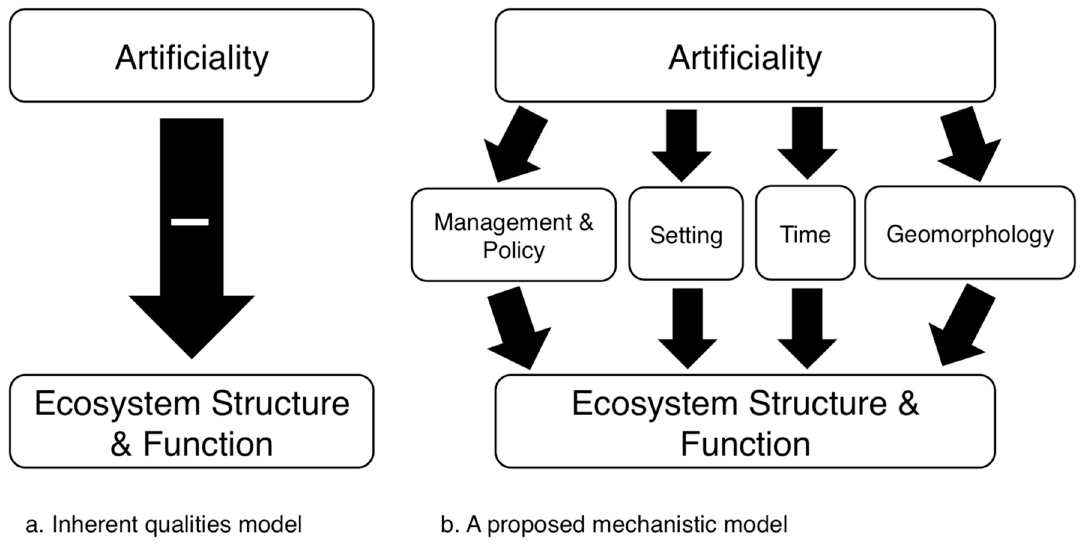
Figure 3. Inherent vs. process-based models of the condition of artificial aquatic systems. ( a ) inherent qualities model; ( b ) process-based model. We suggest that scientists and policy-makers have too readily accepted model ( a ), in which the inherent qualities of artificiality negatively impact ecosystem structure and function, rather than scientifically exploring a mechanistic model such as the one we propose in ( b ), which breaks the influence of artificiality down into multiple processes.